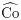
Line and edge disparity, and conspicuity results.
(a, b): Multiscale line and edge coding at λ = 4 and λ = 24. (c): Keypoint map at λ = 24. (d): D
LE map with brightness-coded disparities. (e): Bad pixels (black) with an absolute disparity error ≥ 0.5 [8]. (f): Conspicuity map Co^ after applying lNMS.